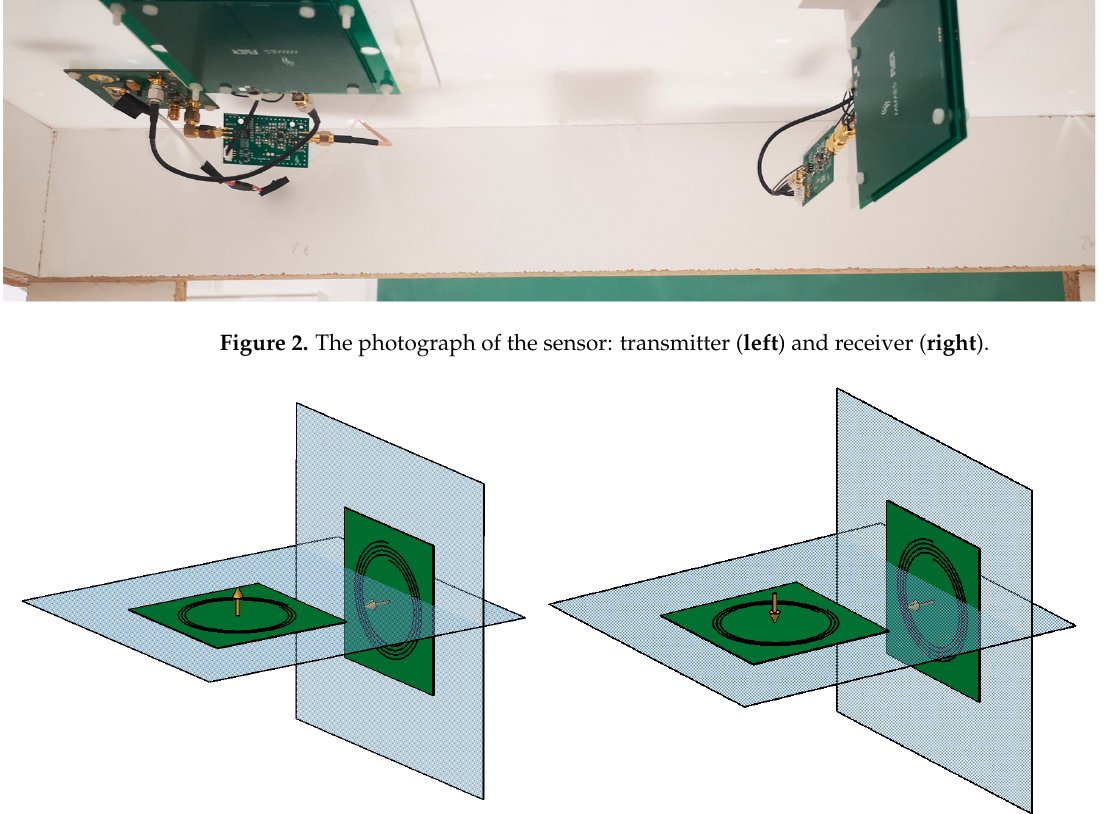
Figure 3. Sensor geometry: ( a ) horizontal transmitter coil oriented upwards, vertical receiver coil, ( b ) horizontal transmitter coil oriented downwards, vertical receiver coil.